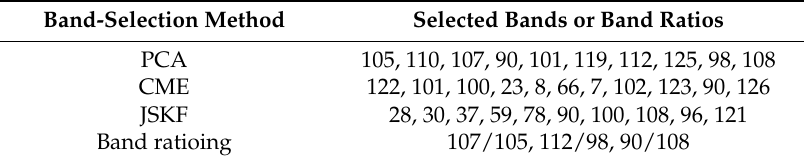
Table 3. Comparison of band indices selected by four methods at Stage